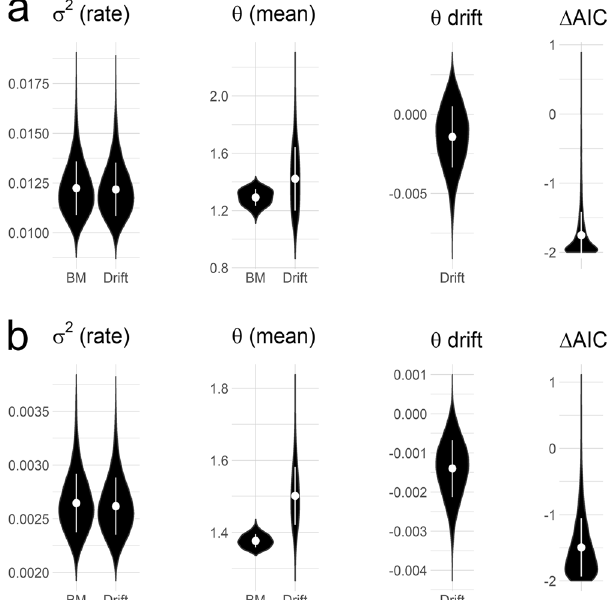
Fig. 3 Evolutionary model fi tting of cruising swimming speed in Palaeozoic early vertebrates. Parameter estimates ( σ 2 , rate of evolution; θ , trait mean; and θ drift, drift of the trait mean) for Brownian motion and drift evolutionary models fi tted to the datasets of ( a ) non-size-normalized speeds and ( b ) size- normalized speeds, respectively. Δ AIC represents the difference between AIC BM and AIC Drift